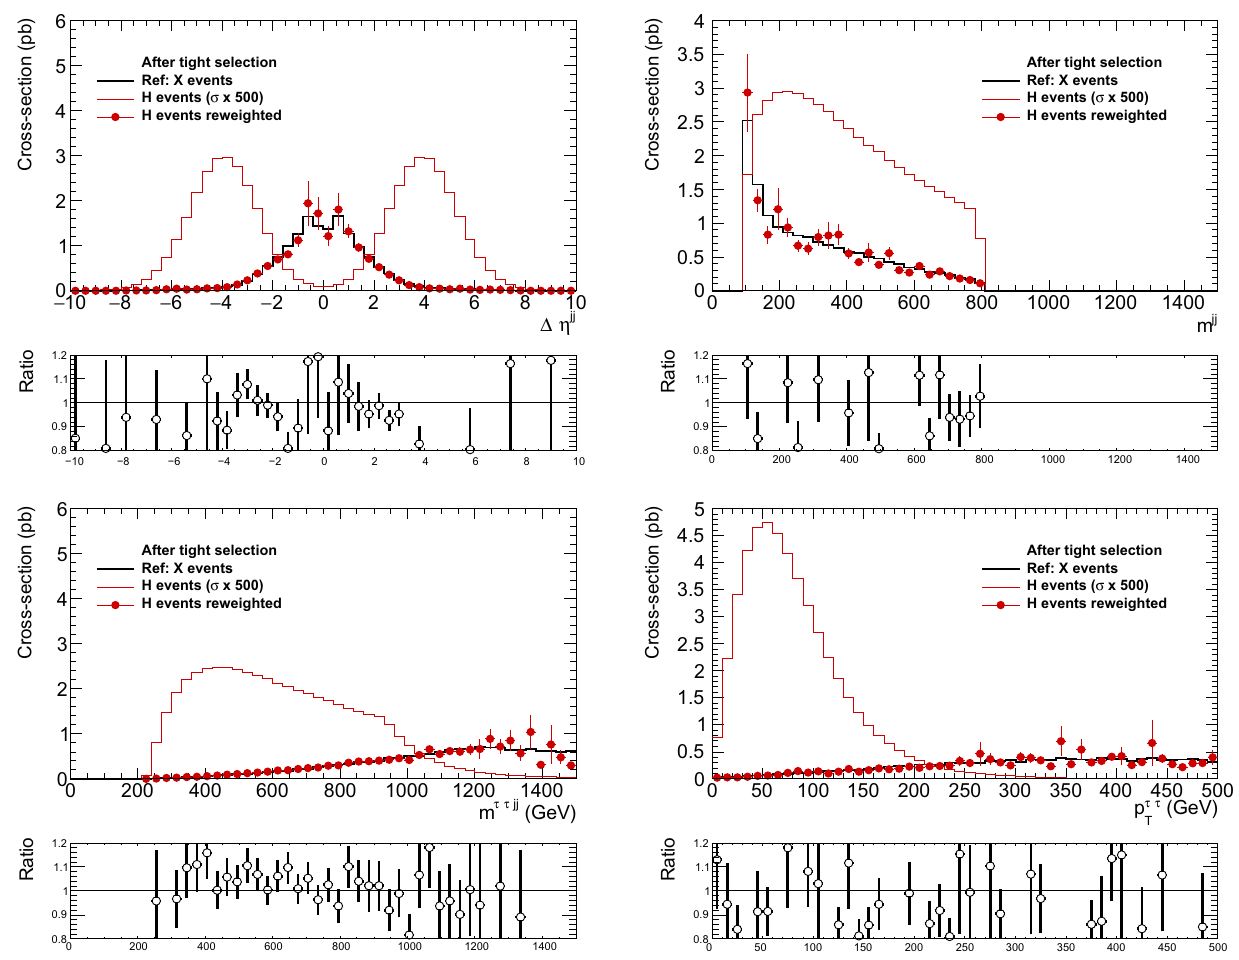
Fig. 3 The H sample re-weighted to the X and compared with the X sample. The H and X widths are 5.75 MeV. Selection cuts: Invariant mass of outgoing particles m ττ jj < 1500